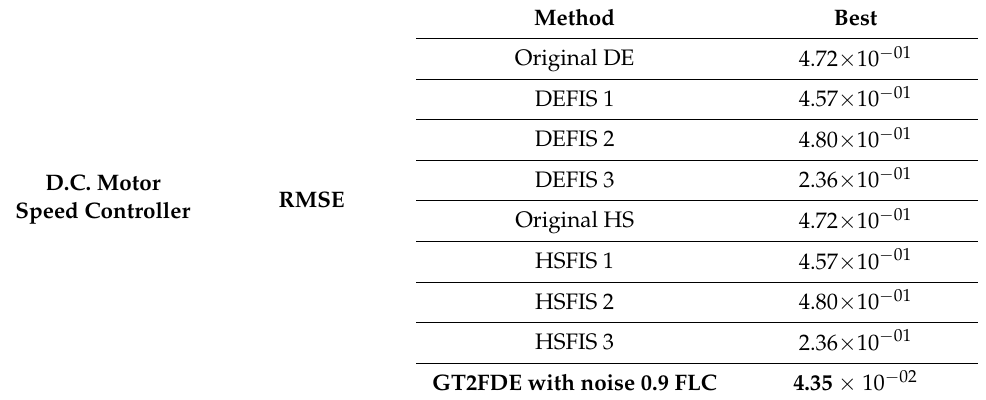
Table 9. Comparison between the GT2FDE and other